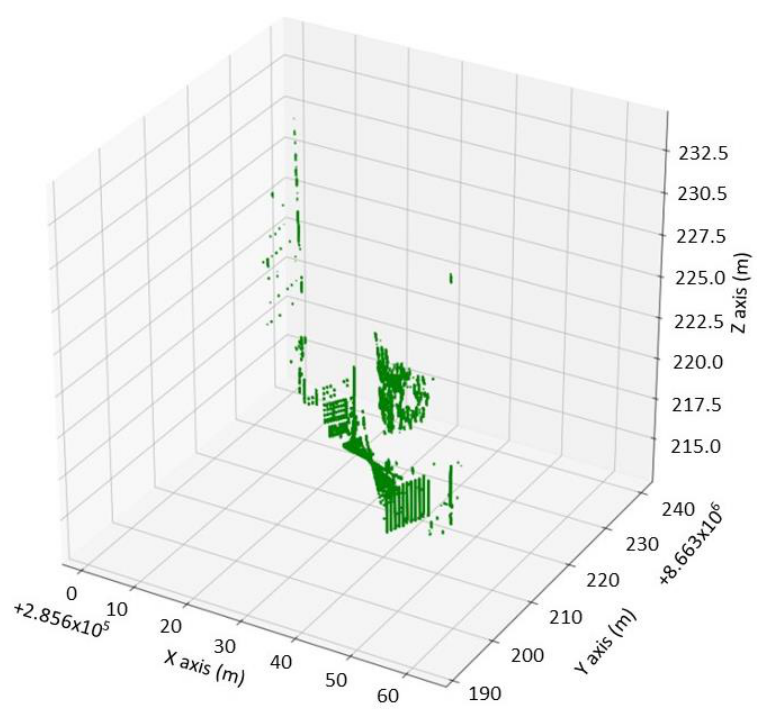
Figure 13 denotes the final point cloud results after adding the dynamic values from the georeferencing equation. Finally, the point cloud is georeferenced in the UAV reference system.